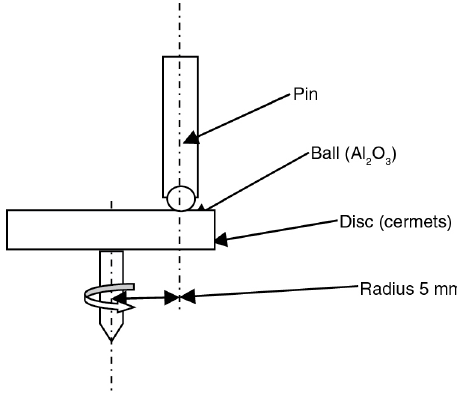
Figure 2: Process of the friction test between ball in Al